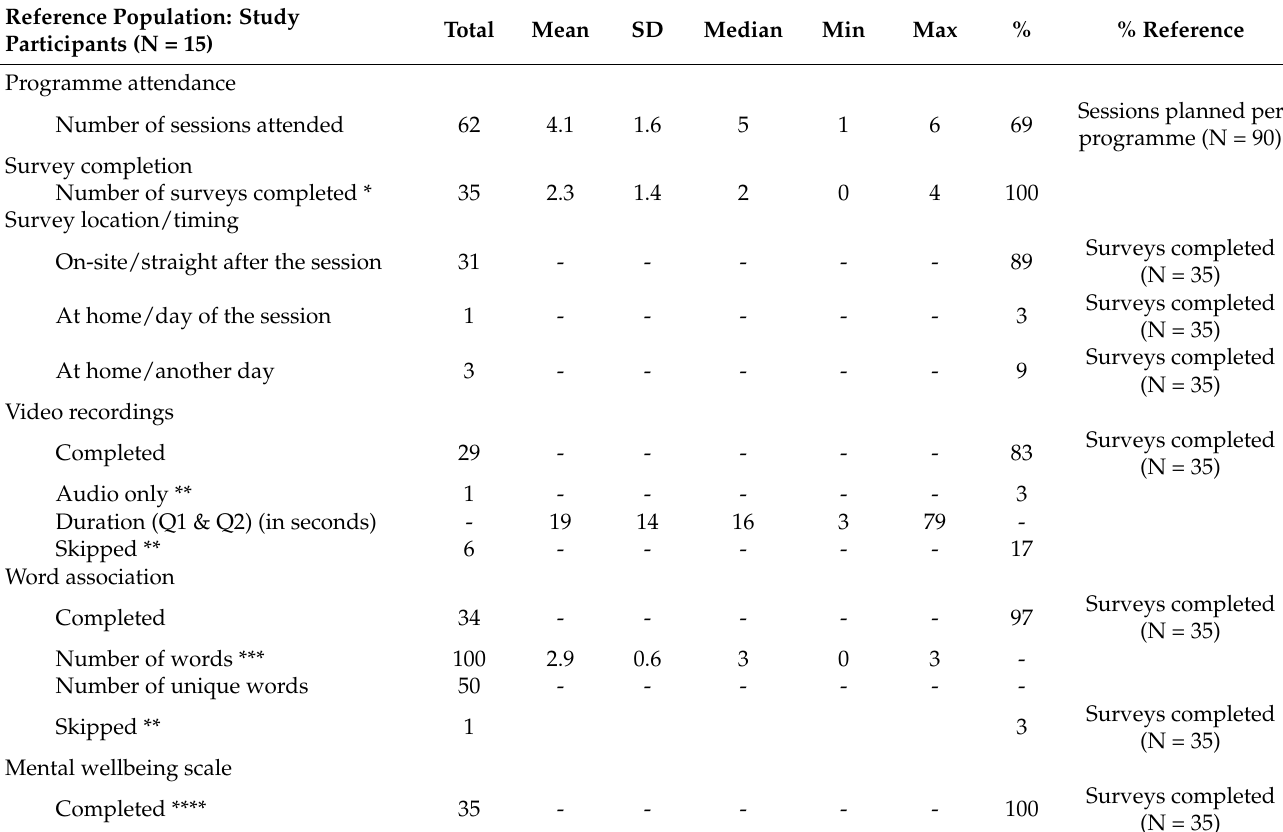
Table 2. Tool use—descriptive